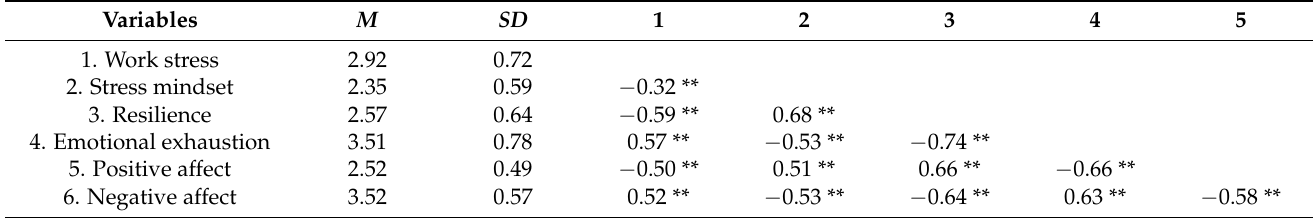
Table 1. Means, standard deviations, and correlations between variables ( N =